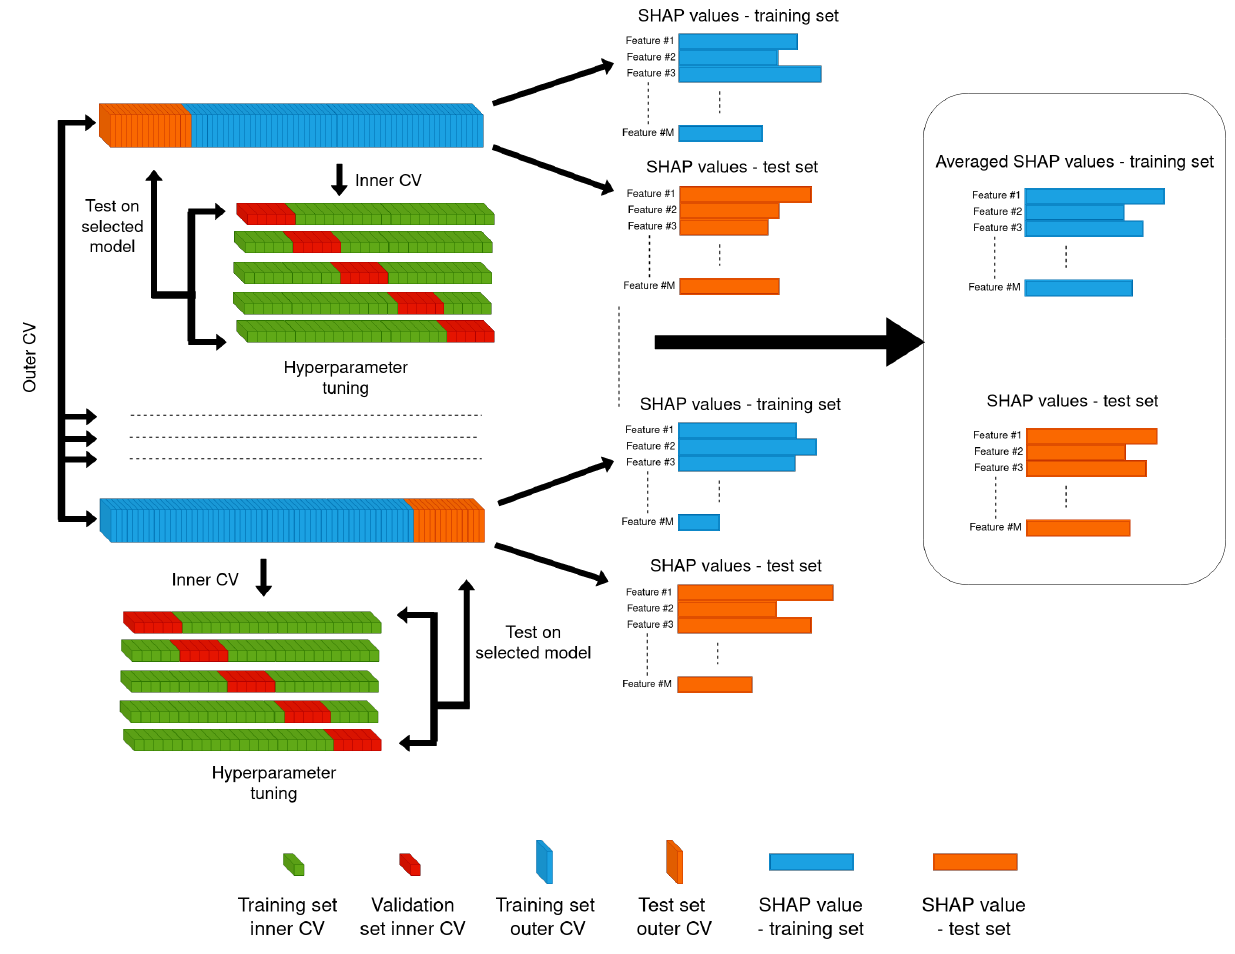
Figure 1. Schematic representation of the computation of representative SHAP values. SHAP values of training and test folds are computed separately for each round of the outer CV. Then, SHAP values are averaged over the training folds. This procedure is repeated K times, and SHAP values for the training and test sets are averaged over the R repetitions (Image adapted from